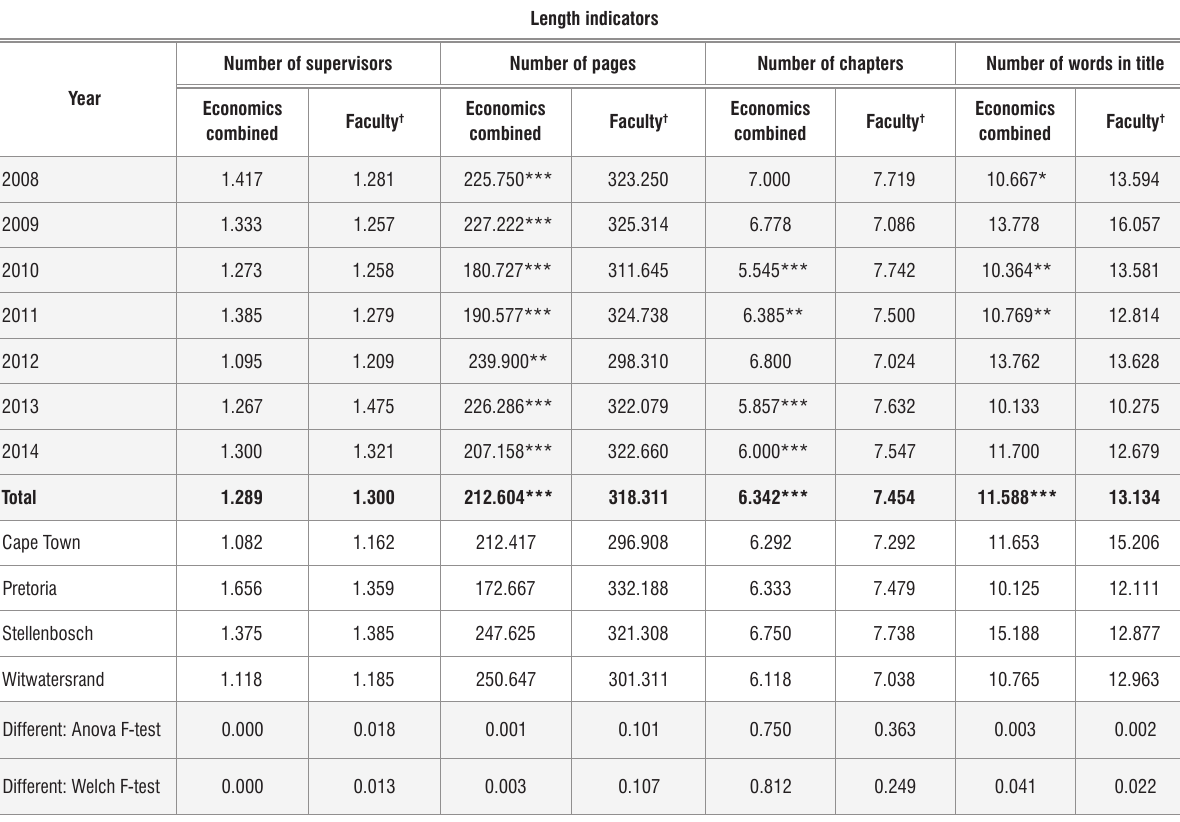
Table 2: Selected attributes of the 114 economics PhDs produced versus the 277 PhDs produced by the rest of the commerce faculty Length